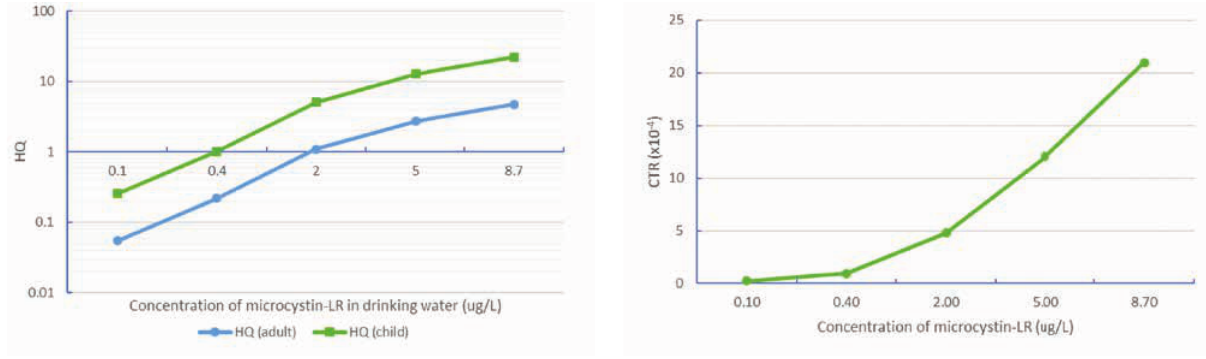
Figure 1: Hazard Quotient (HQ) for drinking water contaminated with microcystin-LR